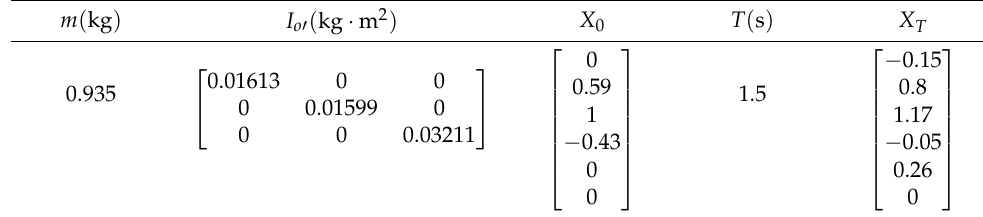
Table 4. End-effector and trajectory planning parameters.